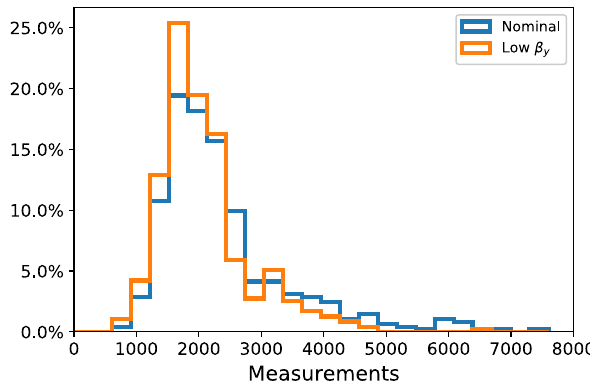
FIG. 10. Histograms of the total number of measurements needed to reach the target luminosity for the nominal lattice and the low- β y lattice. The average tuning time was slightly lower for the low- β y